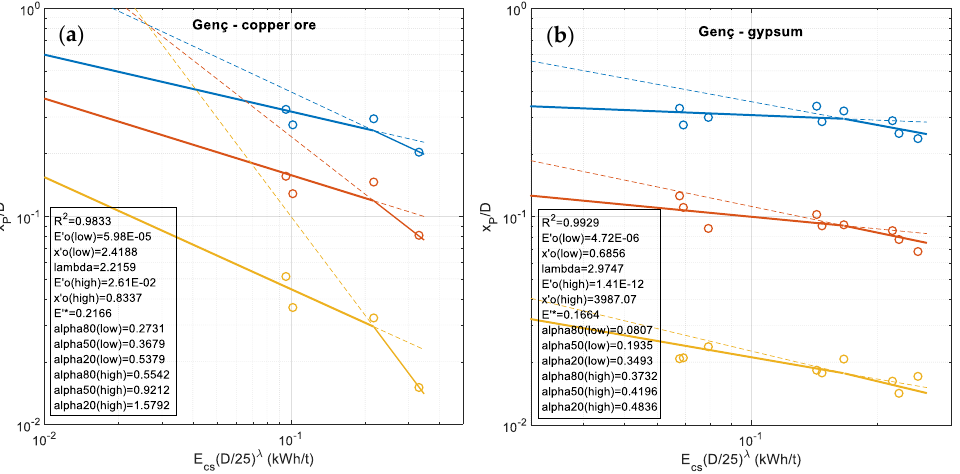
Figure A2. Double fans for Genç ’s et al. [ 24] copper ore ( a ) and gypsum ( b ). Solid lines are the actual high- and low-energy percentile lines, dashed lines are extrapolations out of their ranges of validity. Circles are data. Percentiles colors: blue — 80 %, red — 50 %, yellow — 20 %.